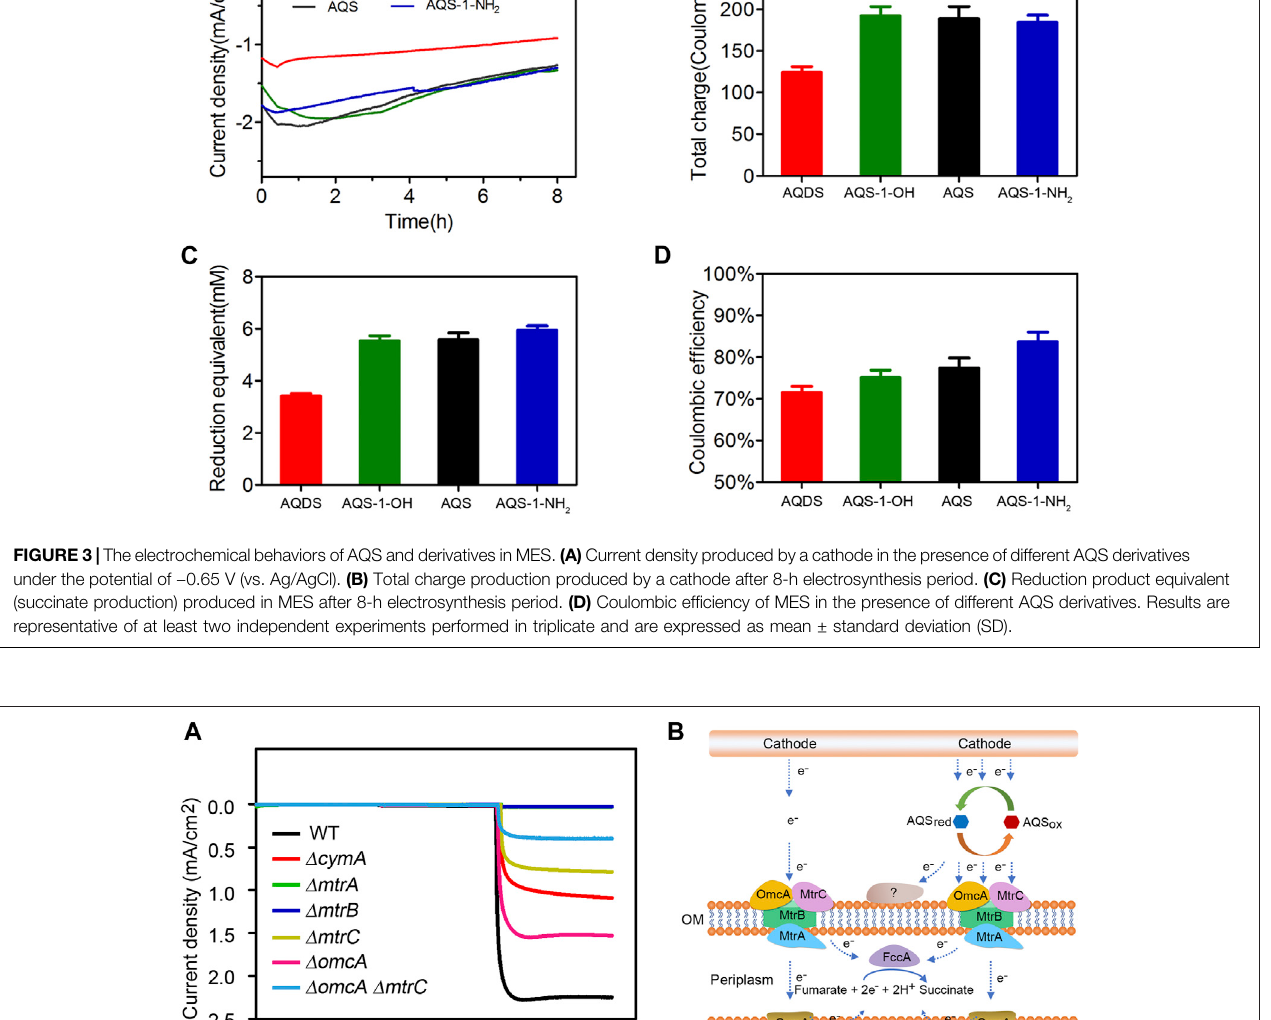
Frontiers in Bioengineering and Biotechnology |